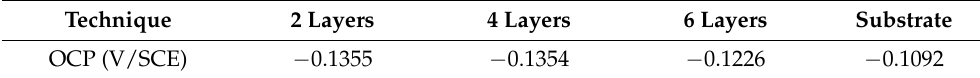
Table 3. OCP measurements after 3 h in 3.5% NaCl water solution immersion at 25 ◦ C.